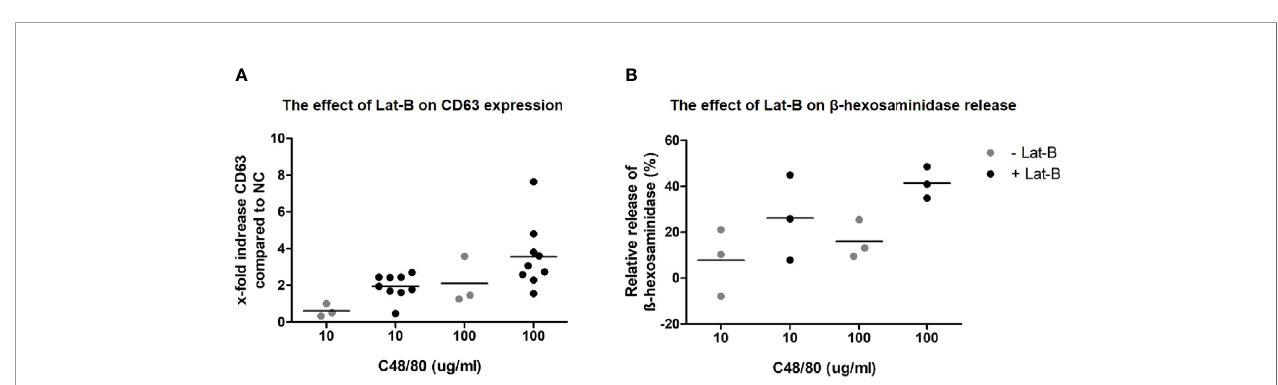
FIGURE 5 | C48/80 induced degranulation of HMC1 with and without Lat-B. (A) Stronger upregulation of CD63 in response to C48/80 stimulation was seen after pre-incubation with Lat-B, with a dose dependent effect. (B) The relative b -hexosaminidase release was increased after pre-incubation with Lat-B compared to without Lat-B, but not reaching statistical signi fi